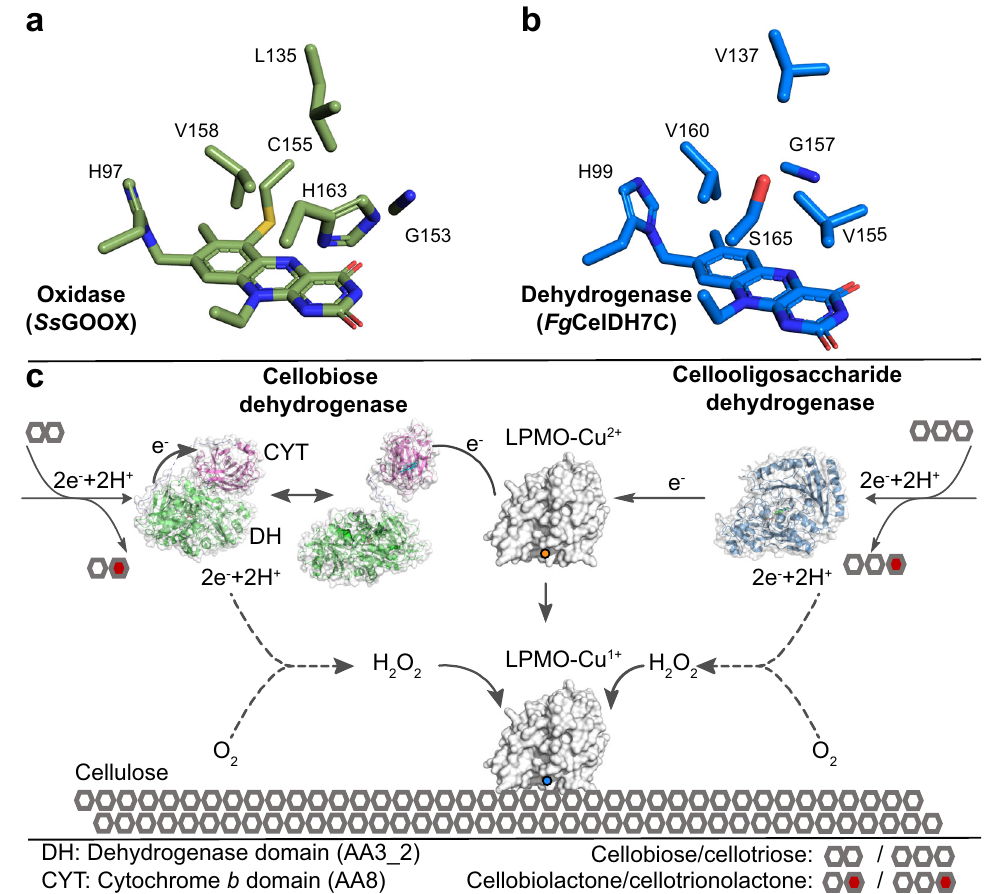
Fig. 6 Oxygen-binding cavity in AA7 oxidoreductases and a schematic model for AA7-LPMO interplay. a , b Putative oxygen-binding cavity in typical AA7 oxidases and dehydrogenases, respectively. The substitution of conserved histidine and glycine in oxidases to serine (or other small residues) and valine in dehydrogenases, respectively, is observed. c Schematic model of the interplay of cellobiose dehydrogenase (CDH) versus the AA7 cellooligosaccharide dehydrogenase with LPMOs during cellulose degradation. Both dehydrogenase classes oxidise cellooligosaccharides to the corresponding lactones. The electrons harvested from this oxidation are stored in the FAD-cofactor and subsequently delivered directly to the LPMO in the case of AA7. The transfer of priming electrons in CDH proceeds fi rst from the dehydrogenase domain to the cytochrome b haem domain in (closed form). A subsequent large conformational change to the open form is required to expose the haem domain to the LPMO active site for electron transfer. The dotted lines signify the low oxidase side-activity from both classes of dehydrogenases, which generates the H 2 O 2 preferred co-substrate to fuel cellulose oxidative degradation by LPMOs. Low levels of H 2 O 2 are also generated at the active site of free primed LPMOs, but this is left out from the fi gure for